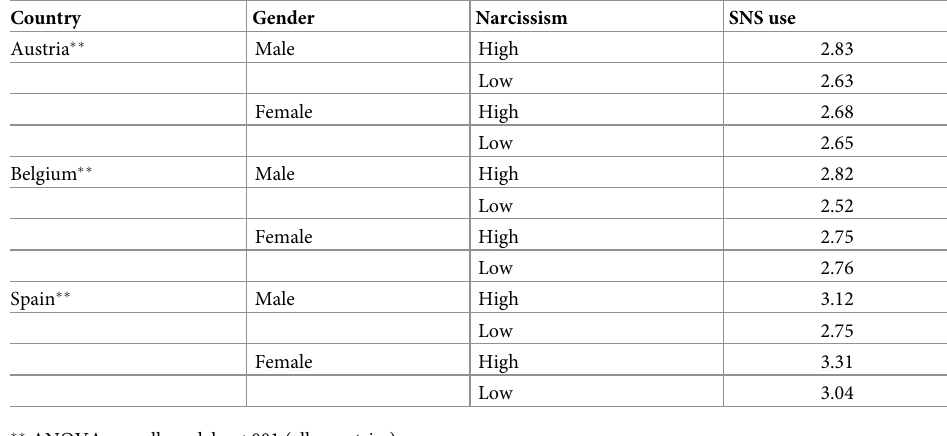
Table 4. Social media use (SNS use) by country, gender, and level of narcissism.